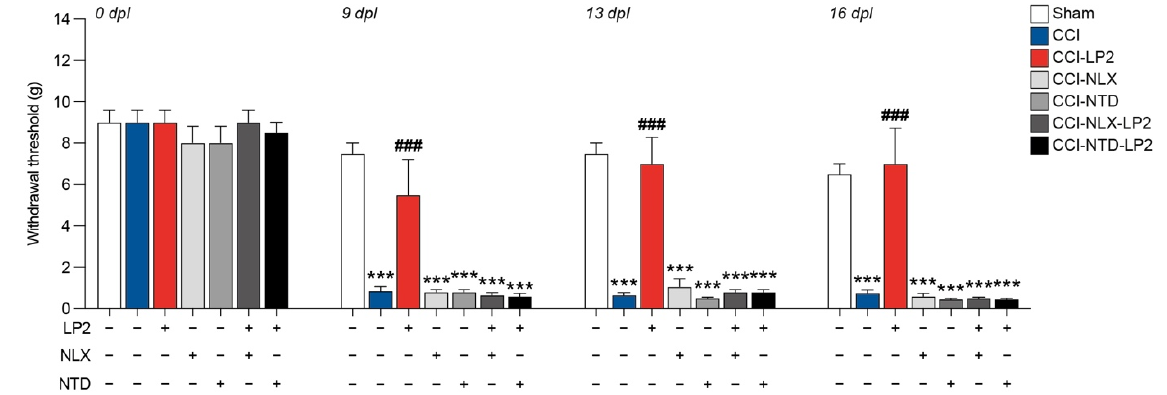
Figure 3. Behavioural analysis of mechanical sensitization of sham and CCI animals. Withdrawal thresholds measured with von Frey’s filaments on sham, CCI-, CCI-LP2-, CCI-NLX-, CCI-NTD-, CCI-NLX-LP2, and CCI-NTD-LP2-treated rats at 0, 9, 13, and 16 dpl. Data are shown as mean ± SEM of n = 4 rats per group. CCI, chronic constriction injury; dpl, days post ligature; NLX, naloxonazine; NTD, naltrindole; g, grams. *** p -value < 0.001 versus sham and ### p -value < 0.001 versus CCI.